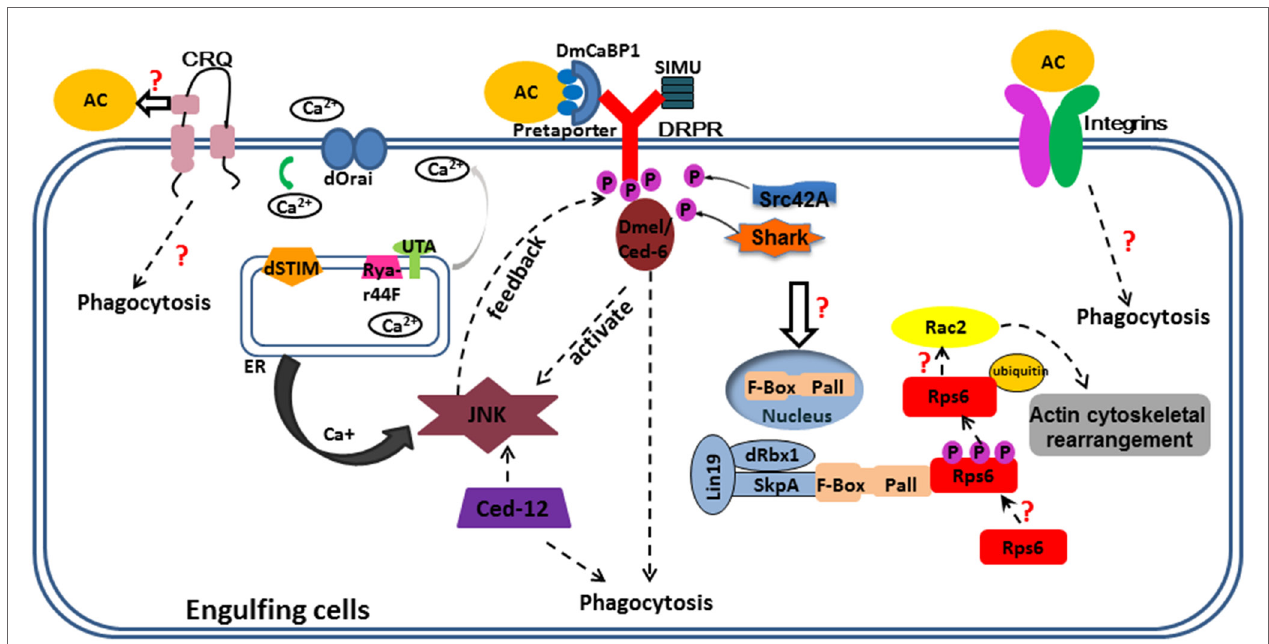
FiGURe 1 | Overview of corpse recognition and disposal in Drosophila . Key components positioned according to their roles in corpse recognition, internalization, and processing. Some important questions are also indicated. Three engulfment receptors located at the plasma membrane. CRQ (Croquemort), a membrane two-path protein, expressed mainly in the macrophages and its ligand and downstream have not studied clearly; Draper (Ced-1), a membrane single-path protein, expressed mainly in glia of CNS and hemocytes, with its ligands are shown in this figure, phosphorylated Draper interact with Ced-6 thus elevates Jun N-terminal kinase (JNK) signal and maintain Ca + homeostasis; JNK promotes Drpr enrichment both in glia and follicular epithelia (under Ced-12 activation). Integrins, a heterodimer protein, function in epithelial follicle cells and hemocytes to engulf cell corpses. The solid arrows mean the relationship between two proteins; the dotted arrows mean the molecular mechanism linking two pathways or proteins unknown. The purple circles with “P” in them mean phosphate groups. The orange circles with “AC” in them mean apoptotic cells; the rectangle outlined by blue lines means engulfment cells; different proteins or molecules are represented by colored shapes as shown in this